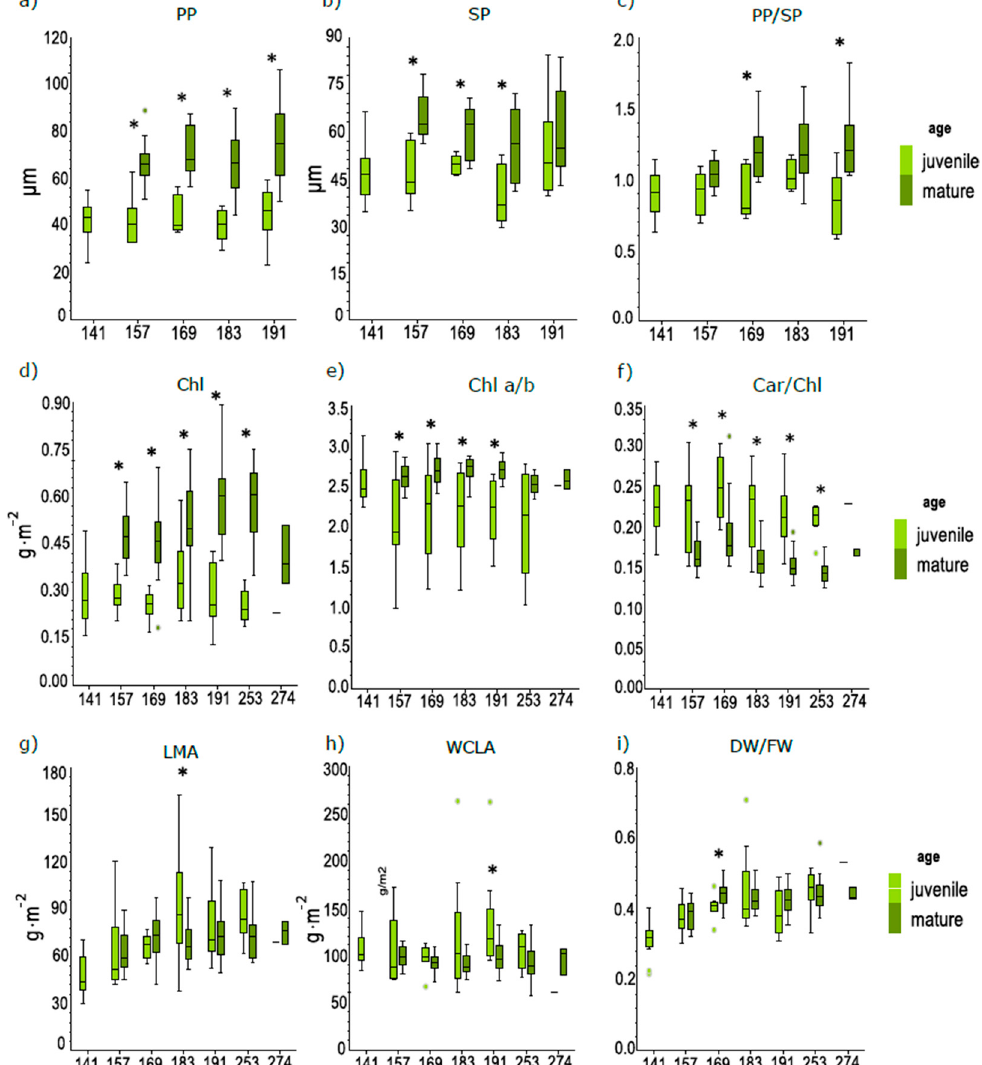
Figure 4. The mean values of anatomical and biophysical traits during the season (DOYs: 141, 157, 169, 183, 191, 253 and 274). Data were pooled according to the leaf developmental category (juvenile and mature) ( a ) PP: palisade parenchyma thickness; ( b ) SP: spongy parenchyma thickness; ( c ) PP/SP: palisade/spongy parenchyma thickness ratio; (the analysis for DOYs 253, 274 were not performed for a–c); ( d ) Chl: chlorophyll a + b content; ( e ) Chl a/b: chlorophyll a/b ratio; ( f ) Car/Chl: carotenoids/chlorophyll ratio; ( g ) LMA: leaf mass per area; ( h ) WCLA: water content per leaf area; ( i ) DW/FW: dry/fresh weight ratio. Juvenile and mature leaves were compared in the particular DOY by one-sample T-test, α = 0.05. Line in color boxes corresponds to median value, bars in boxes show inter-quartile range (IQR); dots correspond to outliers defined as three times IQR; an asterisk denotes significant difference between juvenile and mature leaves at α = 0.05.